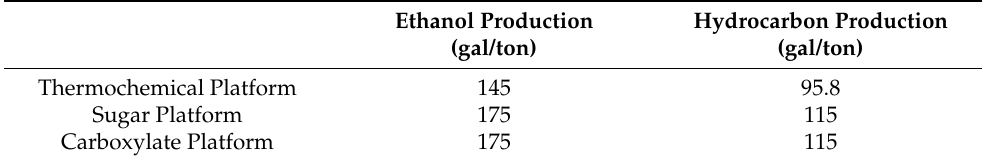
Table 1. Biomass conversion platform and theoretical yield comparison for ethanol and hydrocarbon production [8]. Ethanol Production Hydrocarbon Production (gal/ton) (gal/ton) Thermochemical Platform 145